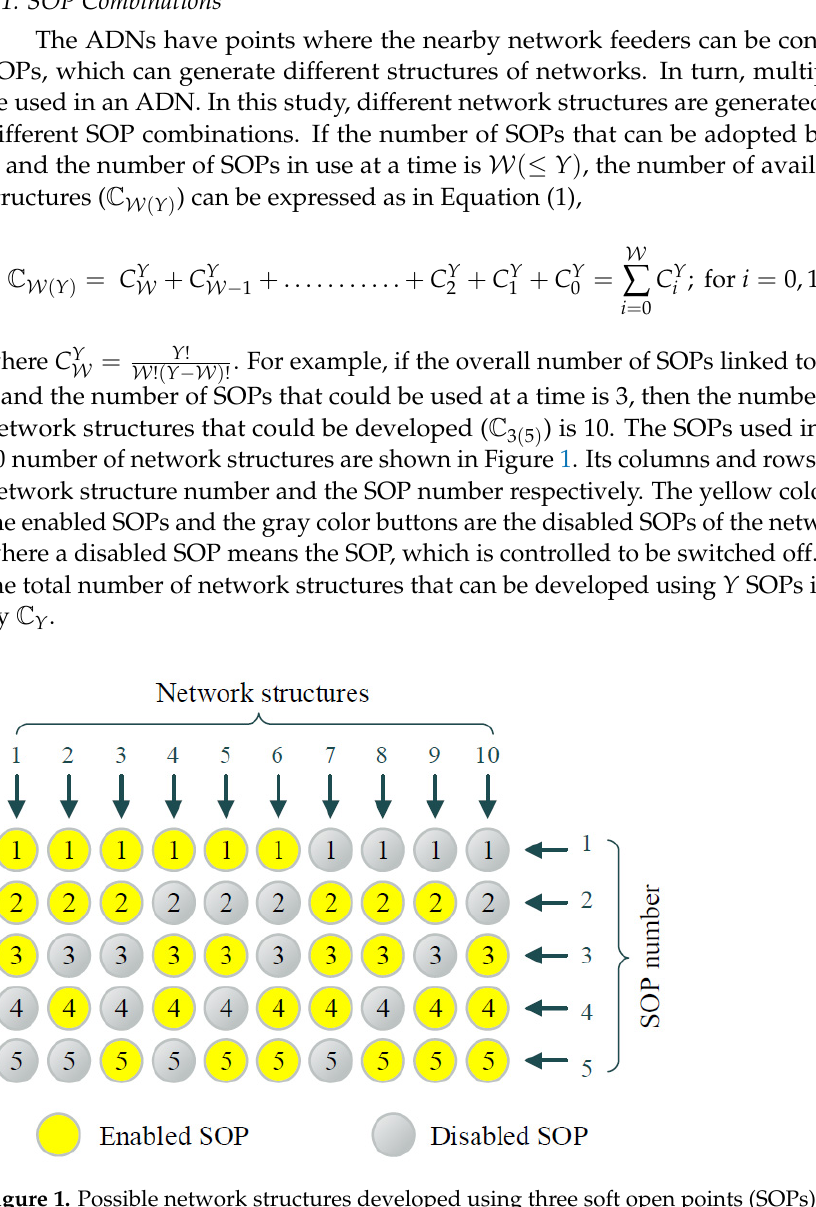
Figure 1. Possible network structures developed using three soft open points (SOPs).